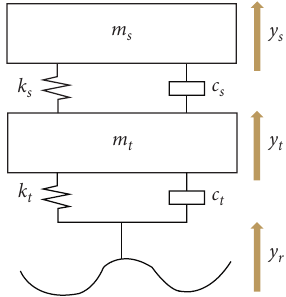
Figure 12: Vehicle-road coupling vibration model. Table 3: Classification standard of road surface roughness in ISO/TC 108/SCN67. Road surface grades